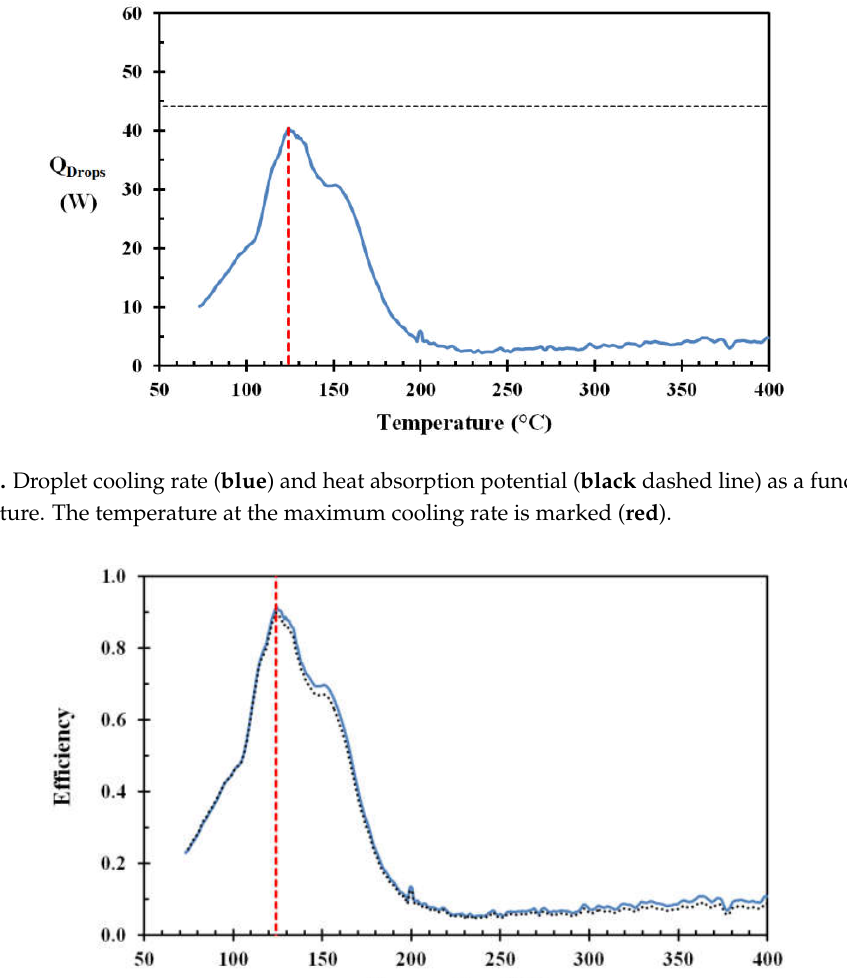
Figure 7. Dimensionless cooling efficiency ( blue ) and dimensionless cooling efficiency related to the